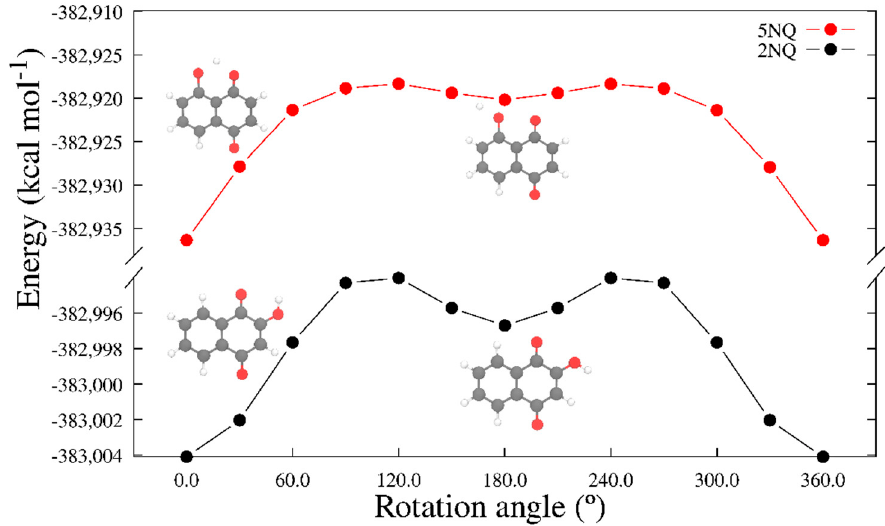
Figure 7. Energy obtained along the rotation of the dihedral angles C1-C2-O10-H13 for 2NQ and C4a-C5-O13-H17 for 5NQ.